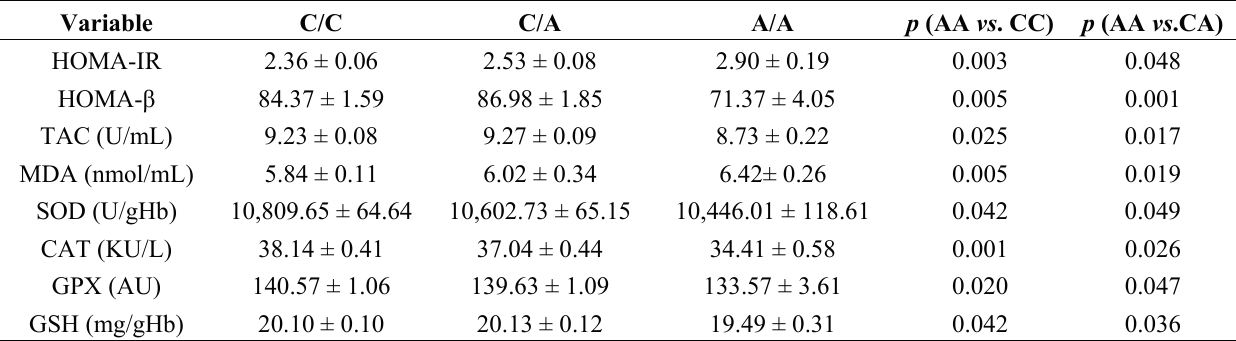
Table 2. Associations of β -cell function, insulin sensitivity, oxidative stress, and anti-oxidative status with genotypes of rs6721961 polymorphism in the study